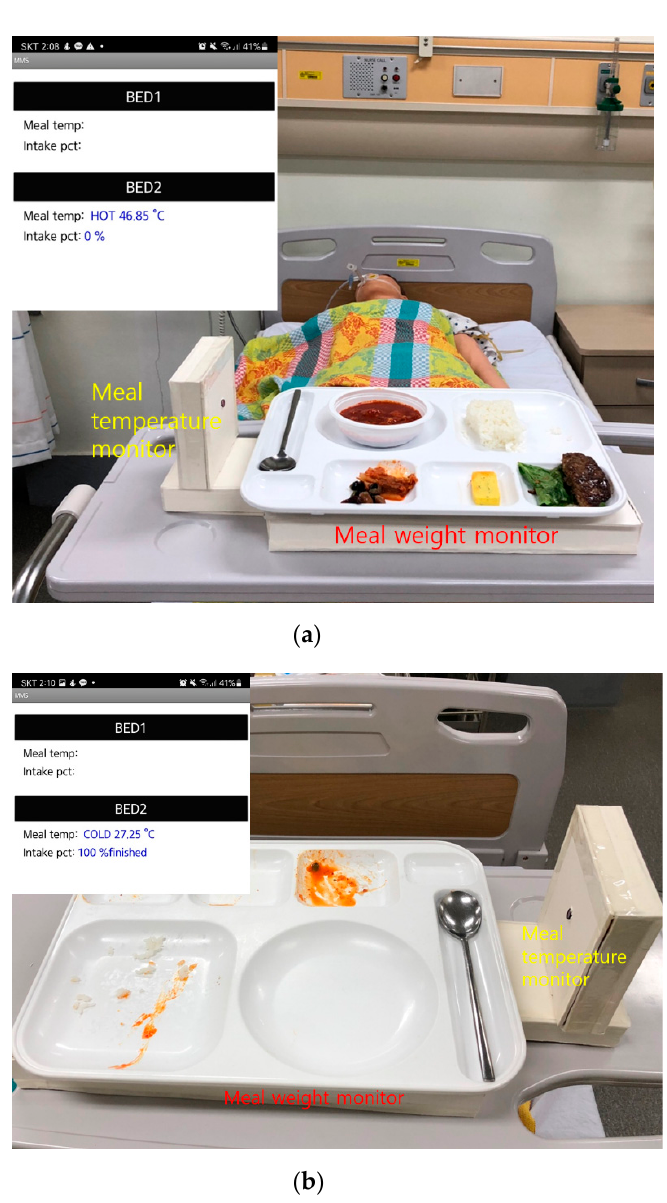
Figure 9. Combined meal monitoring system on a clinical bed in a simulation ward: ( a ) before and ( b ) after the meal intake of a patient.